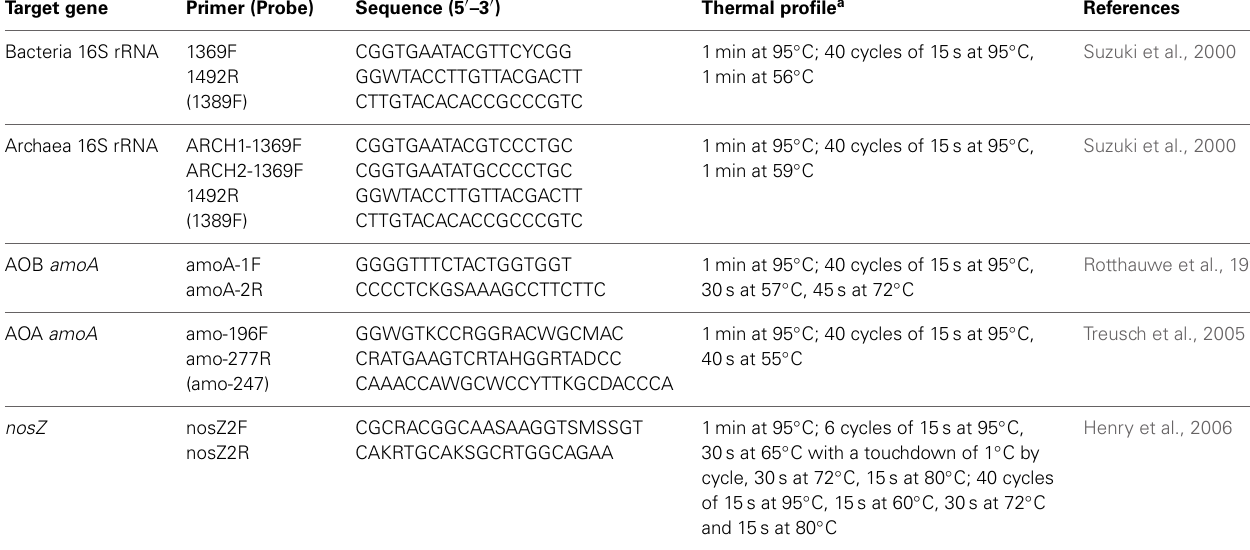
Table 2 | The primers, probes and PCR procedures for real-time quantitative PCR used in this